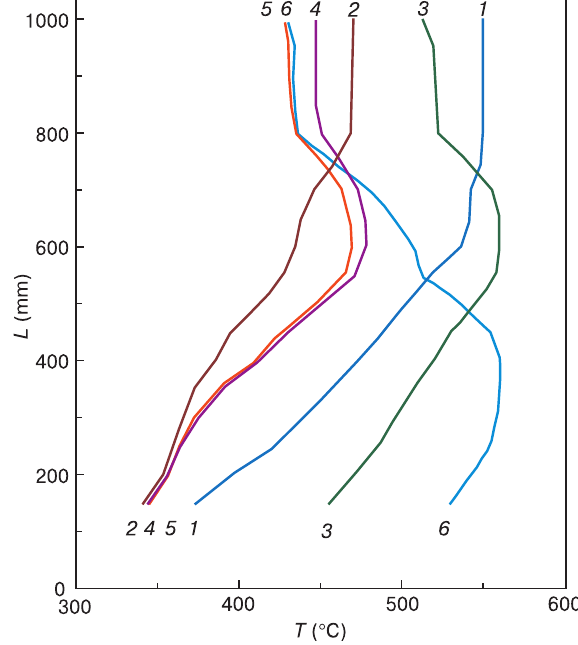
Figure 4. Axial temperature distributions for tellurium refine- ment process stages: ( 1 ) filtration, ( 2 ) first distillation, ( 3 ) first drain, ( 4 ) degassing, ( 5 ) second distillation and ( 6 ) second drain